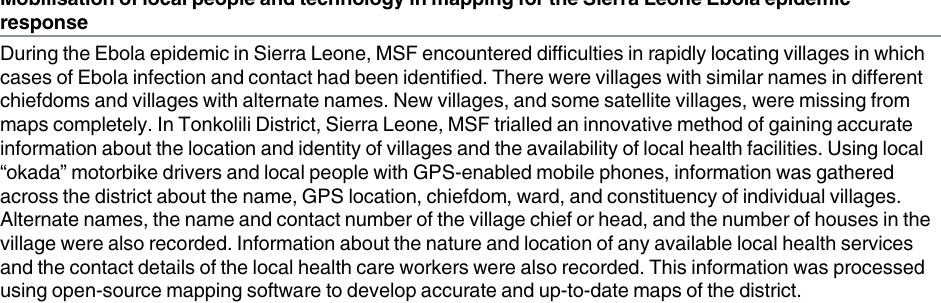
Table 3. Mobilisation of local people and technology in mapping for the Sierra Leone Ebola epidemic response [17].